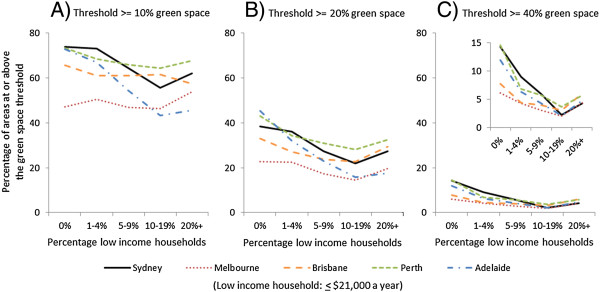
Patterning of green space by neighbourhood socioeconomic circumstance and city, using three binary definitions of green space availability. Panel A: Outcome >=10% green space. Panel B: Outcome >=20% green space. Panel C: Outcome >=40% green space (enlarged inset).